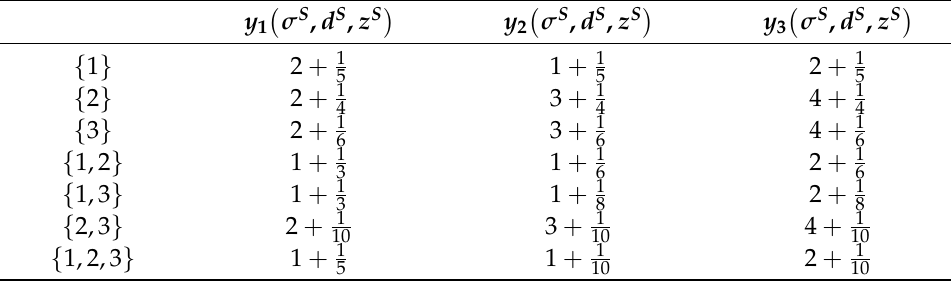
Table 5. The unitary prices associated to the optimal plan above.